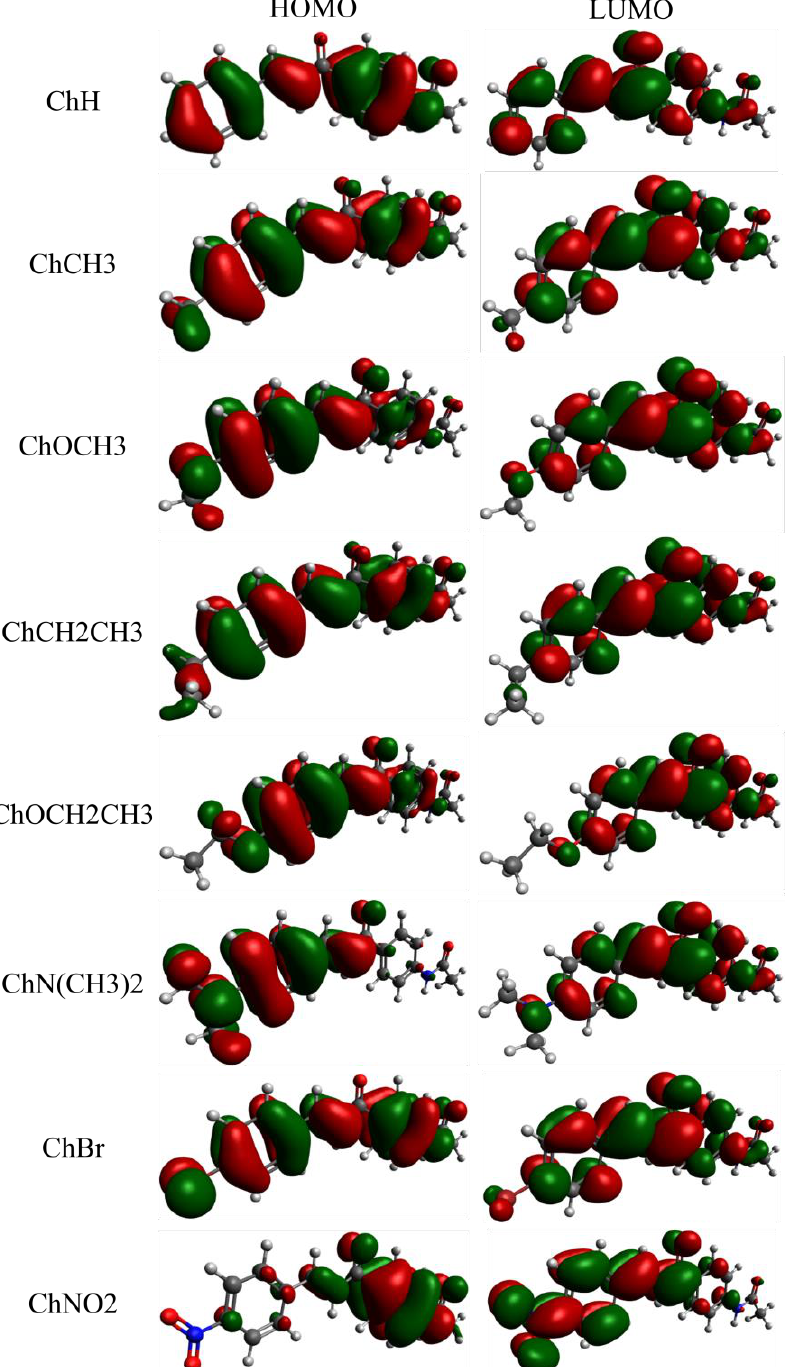
Figure 3. Frontier Molecular Orbitals of all studied compounds obtained through the PCM-CAM- B3LY/6-311++G(d,p) approach for DMSO solvent .